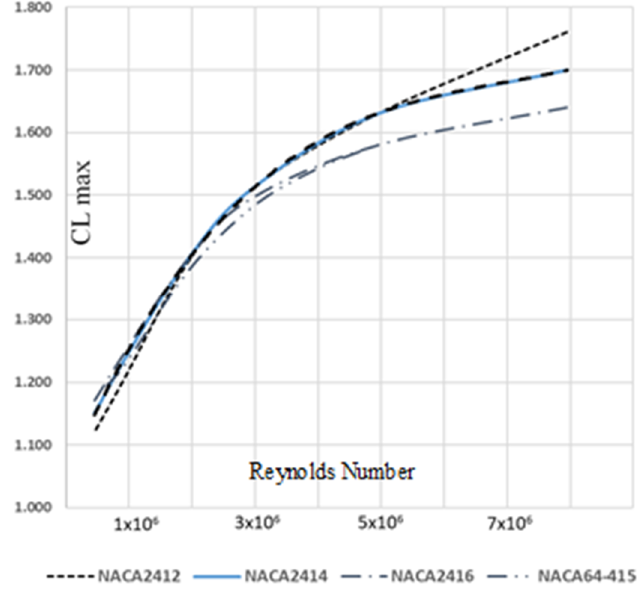
Figure 9. Reynolds number effect on the lift coefficients of typical NACA wing sections.